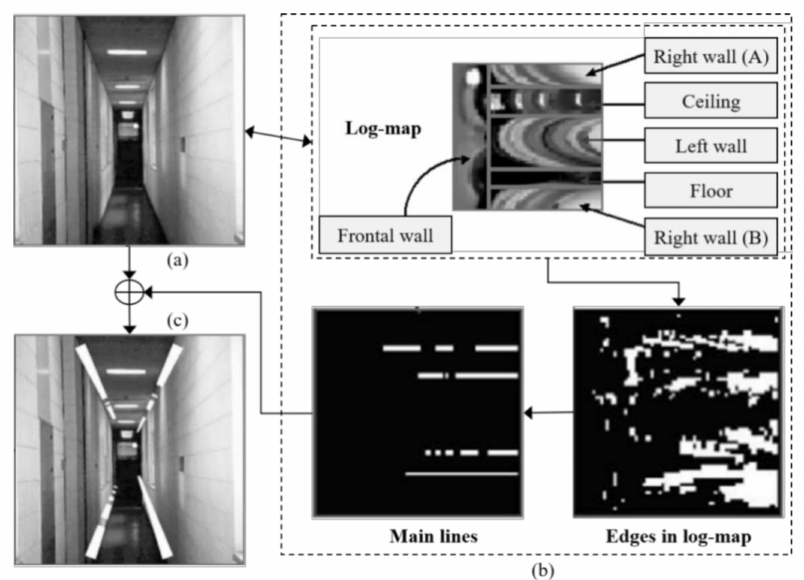
Figure 5. Information extraction of the image depth. ( a ) The original input image. ( b ) Linear detect process with LPT. ( c ) The output